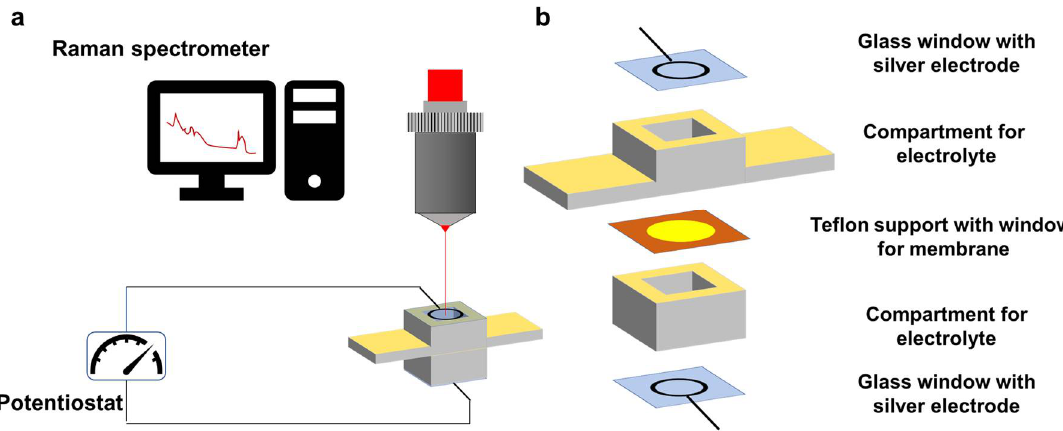
Figure 2. Setup for ion transport experiments ( a ) and the construction of Raman cell ( b ) detailed Raman cell assembly.